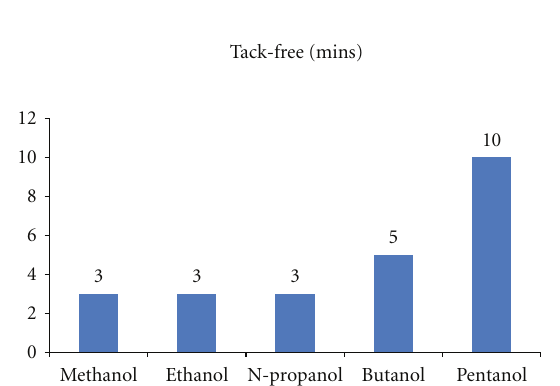
Figure 1: The tack-free time in the room temperature (26 ◦ C temperature and 30% absolute